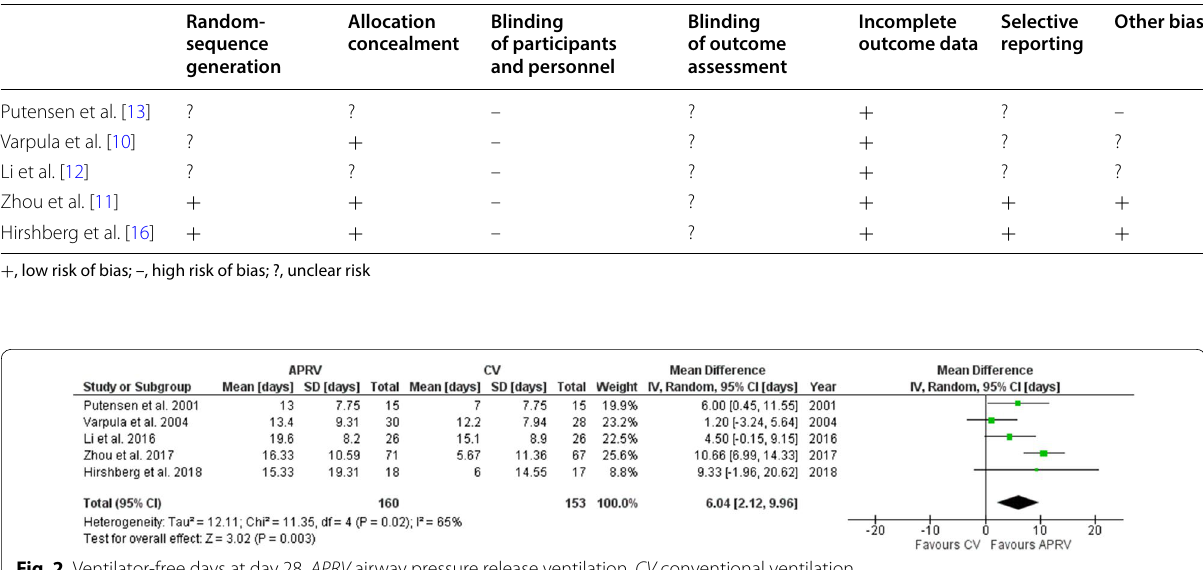
Table 2 Quality assessment of the included studies